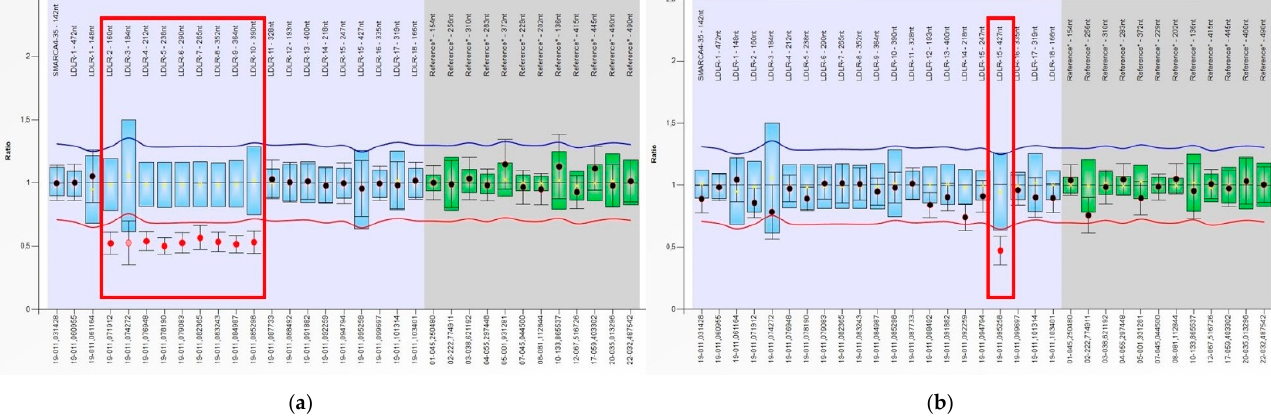
Figure 2. MLPA analysis shows a heterozygous deletion (ratio of ~1.5) of LDLR exons 2–10 in patient P33 ( a ) and of LDLR exon 15 in patient P5 ( b ). The ratio charts of the patients with a familial hypercholesterolemia phenotype were generated by means of SALSA MLPA Kit P062. Each red dot below the red curve represents a deletion. The probes whose data do not go outside the blue and red curves represent two wild-type copies of the LDLR gene.